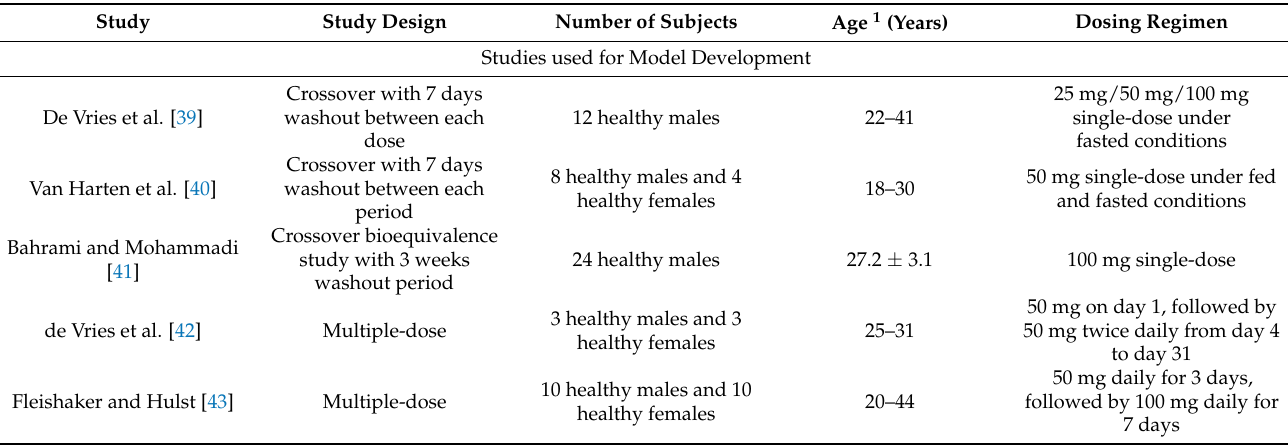
Table 2. Published data used in fluvoxamine model development and